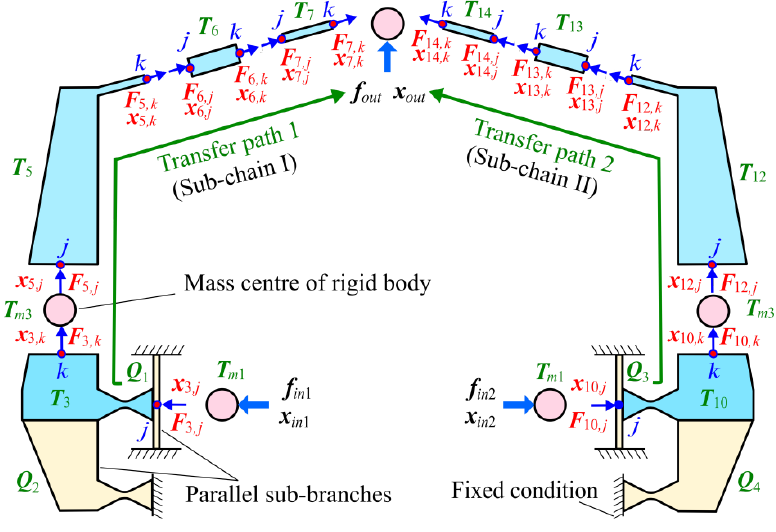
Figure 7. Discretized building blocks of the displacement amplification mechanism.